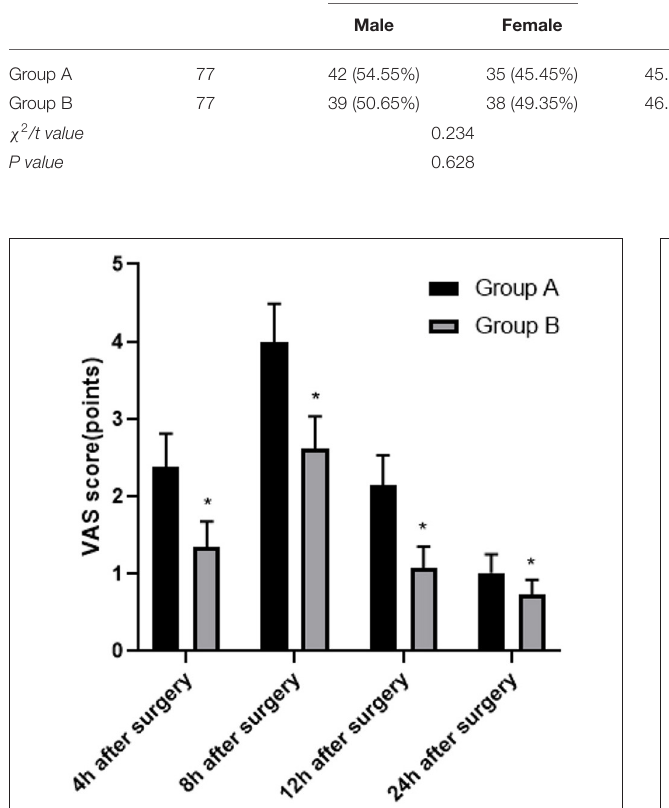
TABLE 1 | Comparison of two groups of general information. Group